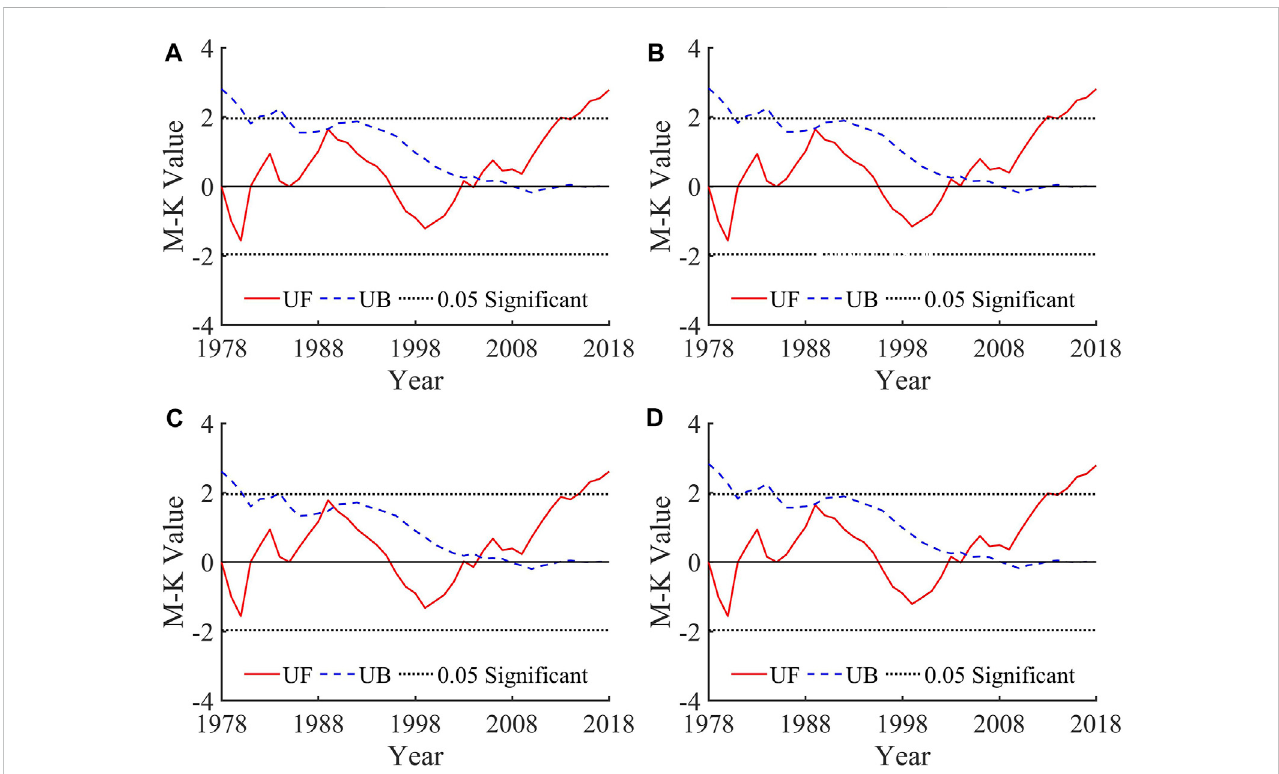
FIGURE 4 Abrupt change test results of the ecological base fl ow of the four sections. (A) Niya Reservoir. (B) 818 Canal. (C) Niya Station. (D) Niya